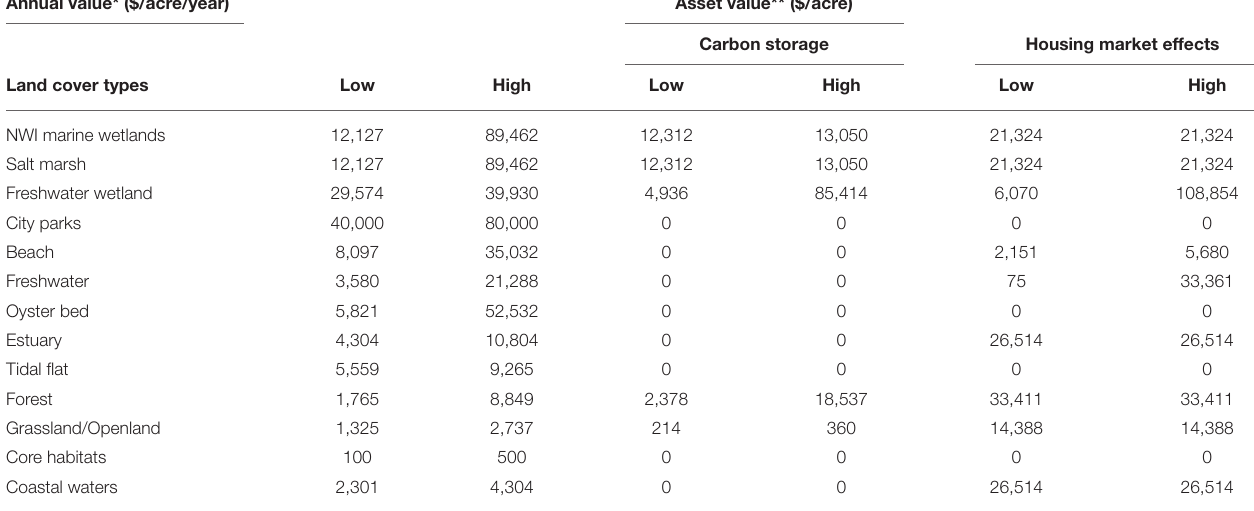
TABLE 2 | Unit ecosystem service values (2016$).